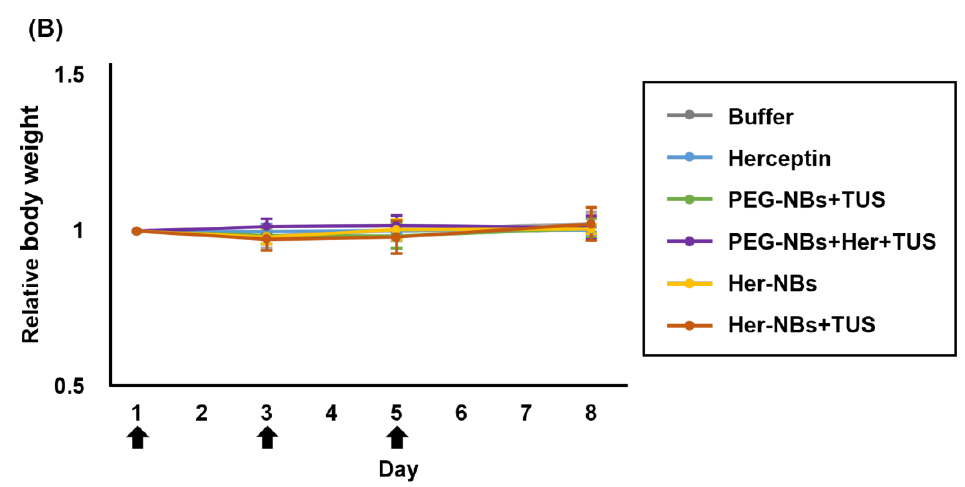
Figure 5. In vivo efficacy of the combination of Her-NBs and TUS exposure against SKOV3 tumor models. Tumor growth rate ( A ) and changes in body weight ( B ) on day 8. Tumor-bearing mice (tumor volume: approximately 65 mm 3 ) were injected with PBS, Herceptin (0.8 µ g/head), or NBs three times every other day. The black arrows indicate treatment days. The tumor was exposed to TUS (frequency, 1 MHz; duty, 50%; intensity, 1 W/cm 2 ; time, 2 min) immediately after injection in the TUS-exposure groups. Relative tumor volumes and relative body weights are expressed as multiples of the initial volumes on day 1. Data = mean ± SD ( n = 4). * p < 0.05 (one-way ANOVA followed by the Tukey’s